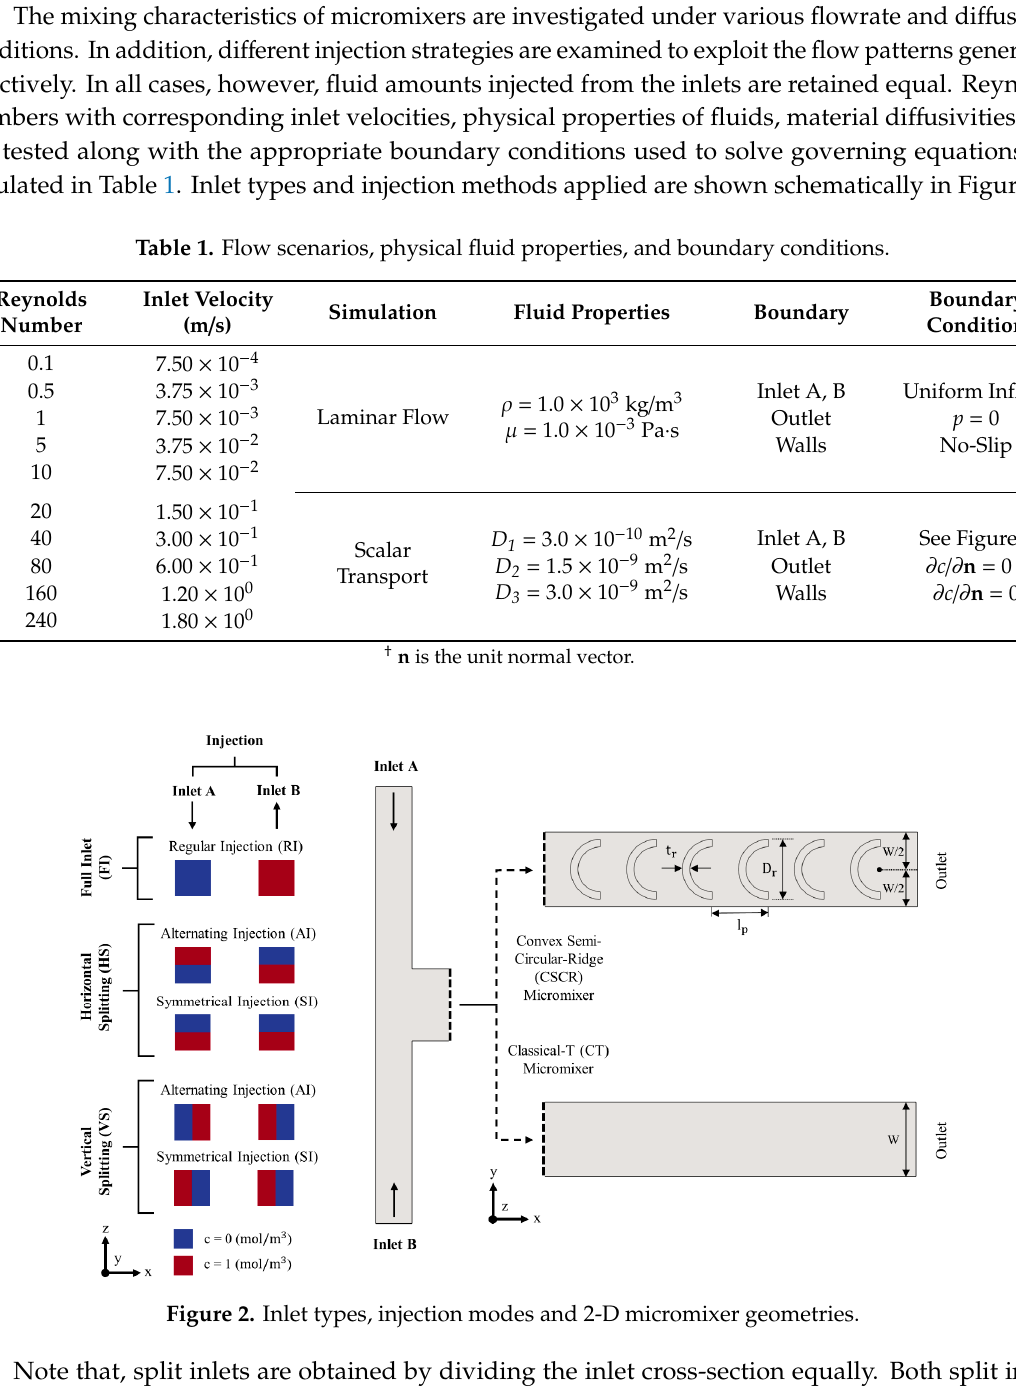
Table 1. Flow scenarios, physical fluid properties, and boundary conditions.